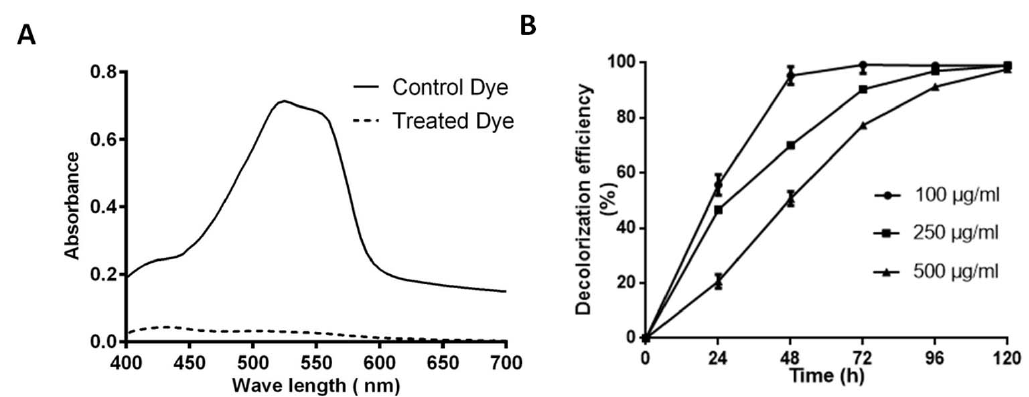
Fig. 3. Absorption spectra of control and SK1 treated 100 µg/ml Acid Red (AR)+Cr(VI) after 48 hours incubation (A), Decolorization percent of AR at different concentration 100, 250 and 500 µg/ml with initial 100 µg/ml Cr(VI) (B).